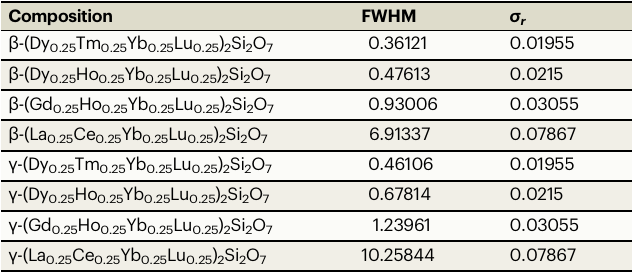
Table 2 | The FWHM and σ r parameters for the studied ensembles